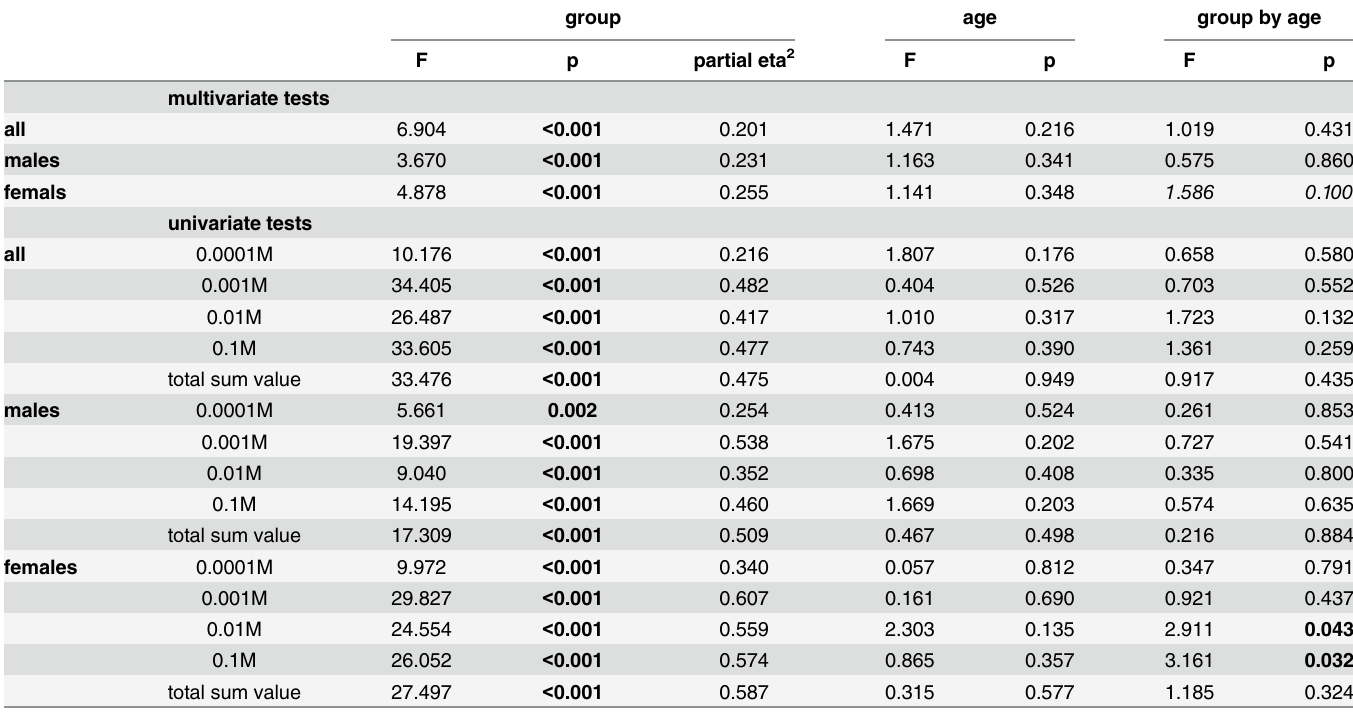
Multivariate and univariate test results of MANOVA with niacin scores included as dependent variable, age as covariable and group as between-subject factor. Results are also presented for subgroups of males and femals. Bold numbers: results p < 0.05; italics: results at trend level p <